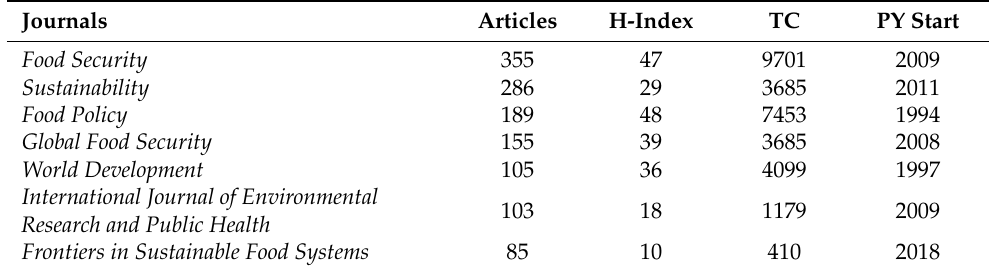
Table 2. Top 7 journals published from 1991 to 2021 in the field of food security influence.